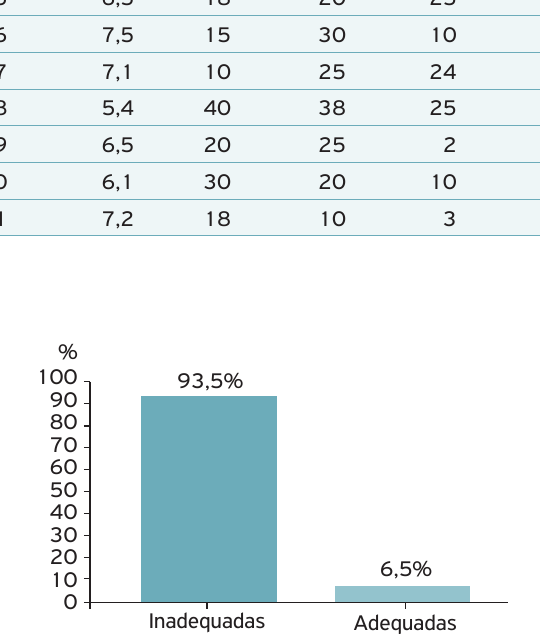
AGRADECIMENTOS Agradecemos aos produtores que colaboraram para a reali- zação deste estudo, sendo que eles receberam laudos com os resultados das análises para as devidas adequações.